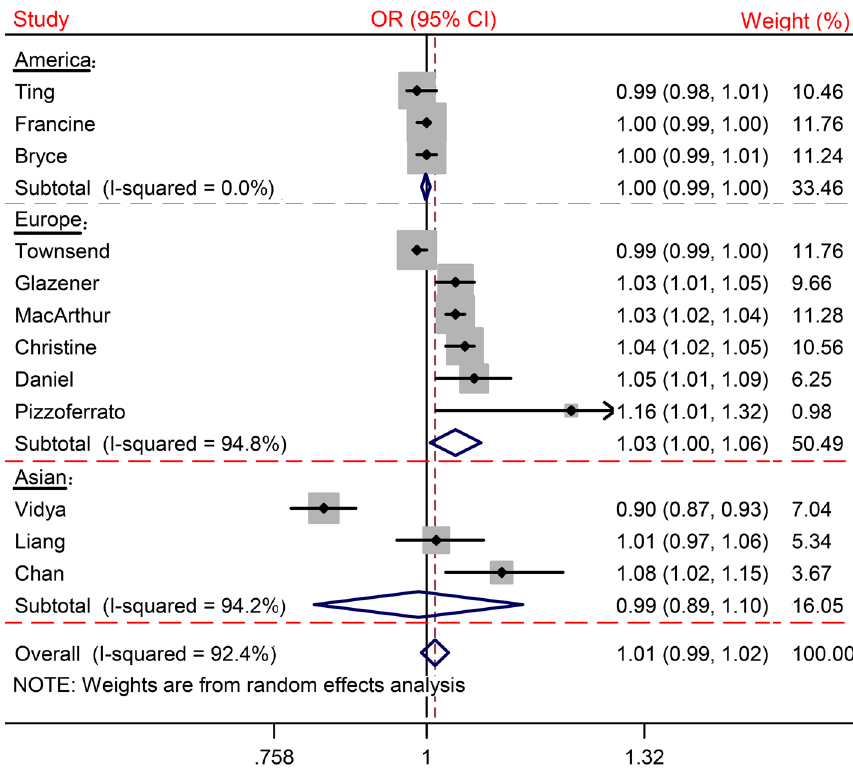
Figure 2. Forest plot of study-specific relative risk statistics for UI per 1-year increment of age at first